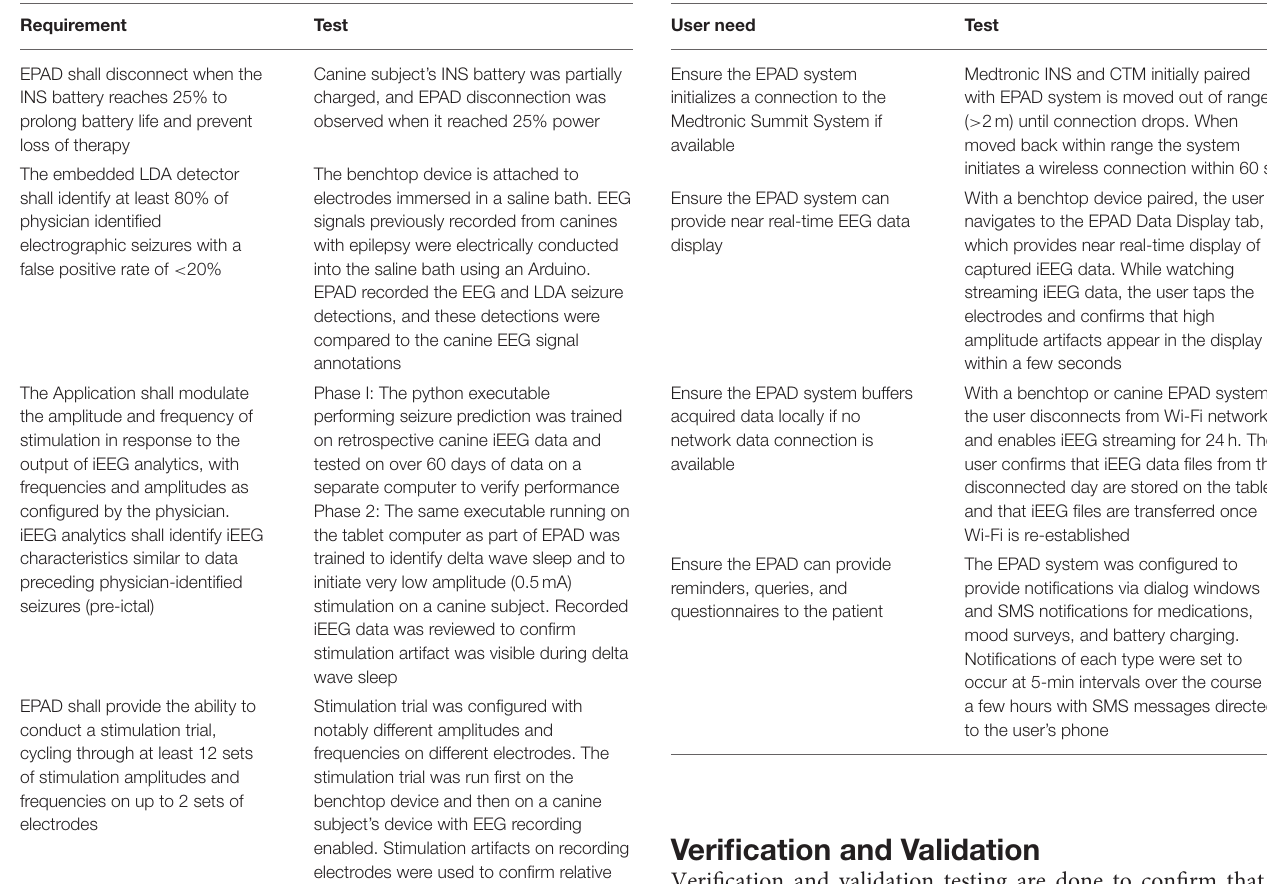
TABLE 1 | Verification tests used in the EPAD quality system. TABLE 2 | Validation tests used in the EPAD quality